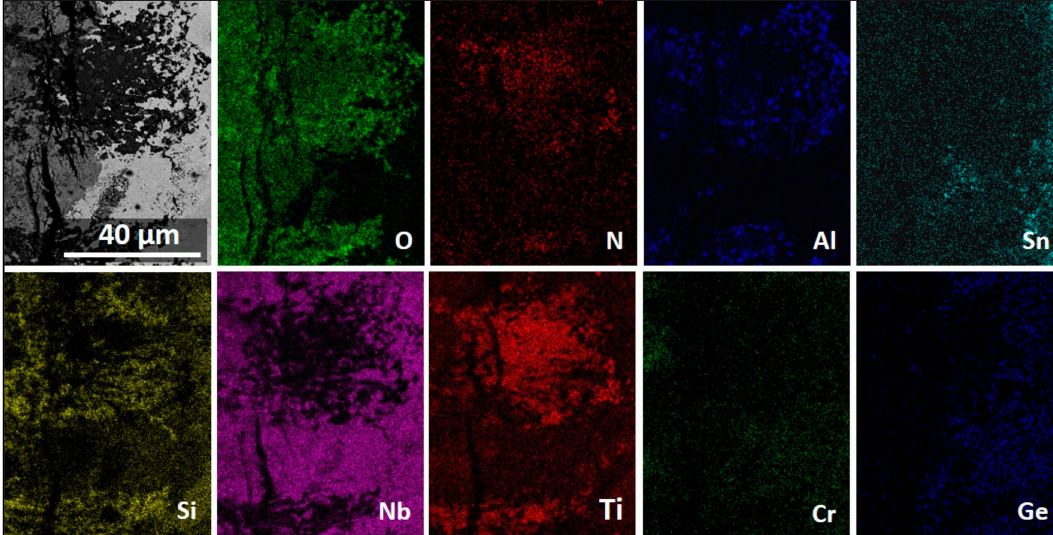
Figure 14. BSE image and X-ray elemental maps of a cross-section of the scale / substrate interface of the alloy OHS1 alloy after isothermal oxidation in air at 1200 ◦ C. The selected area corresponds to the yellow box in Figure